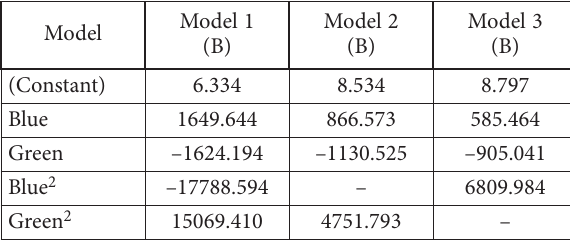
Table 8. Coefficients values of the best regression models